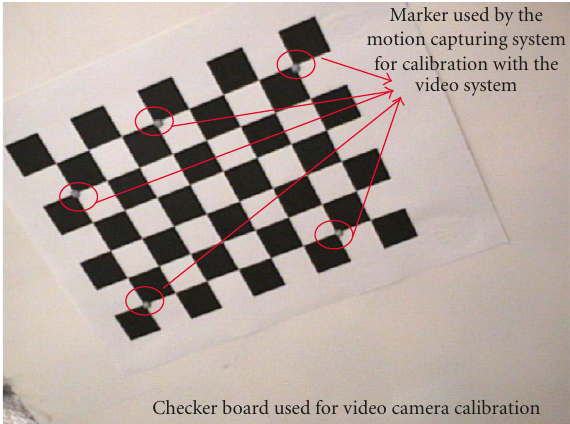
Figure 14: Checker board pattern for calibration between video camera coordinate system and Vicon camera coordinate system. Re- flectance markers are put at specific locations.